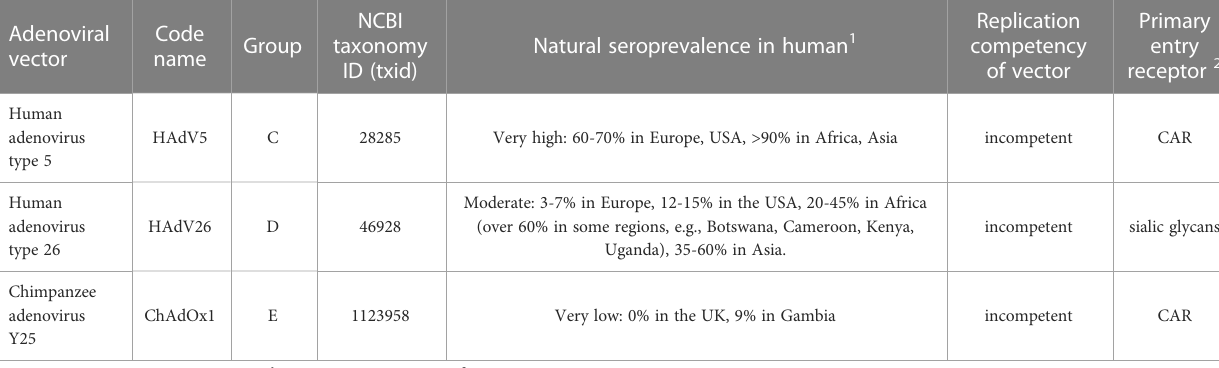
TABLE 2 The overview of adenovirus vectors employed in COVID-19 vaccines.